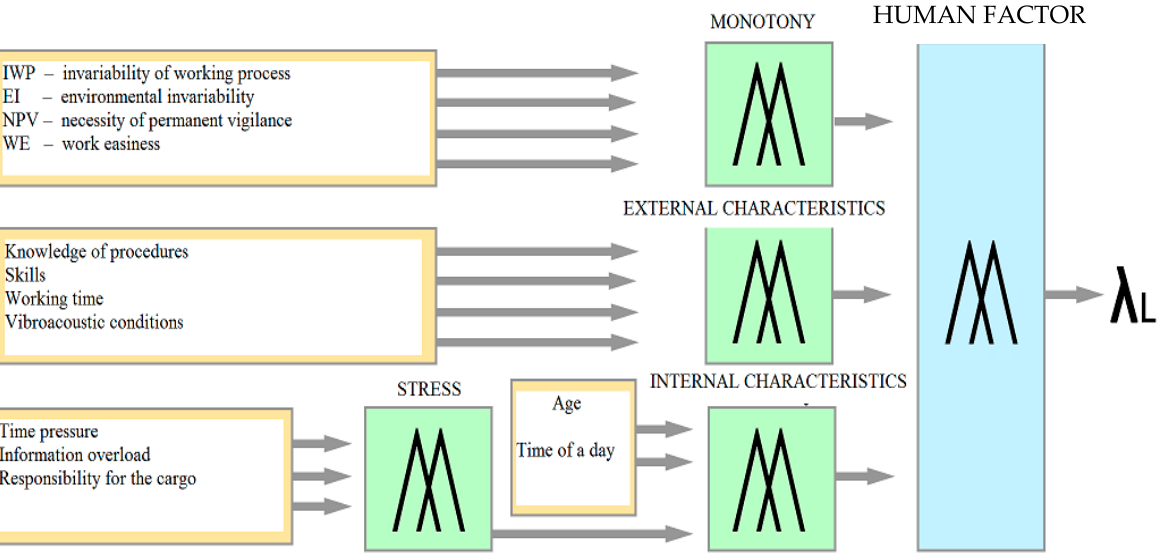
Figure 3. Heuristic model of intensity of accidents caused by driver mistakes.